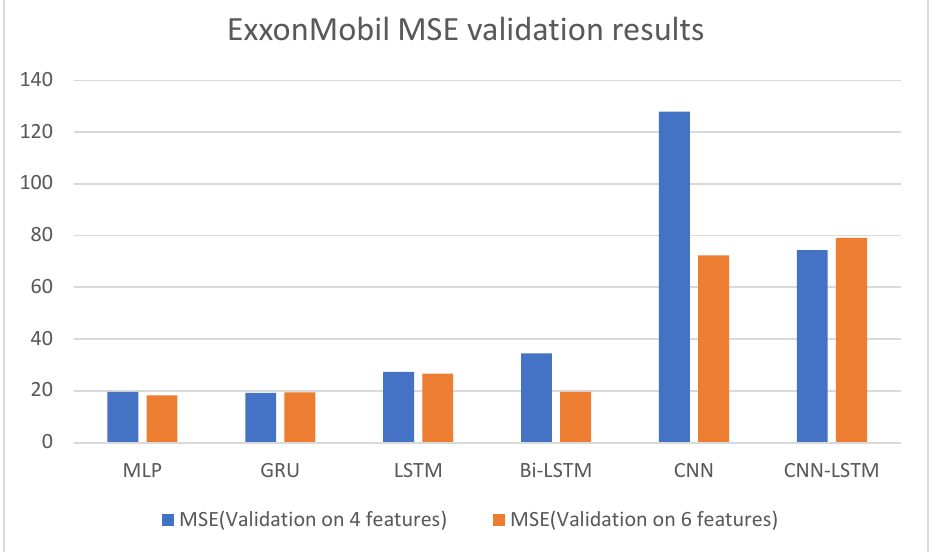
Figure 11. The visualization of the MSE results of ExxonMobil .